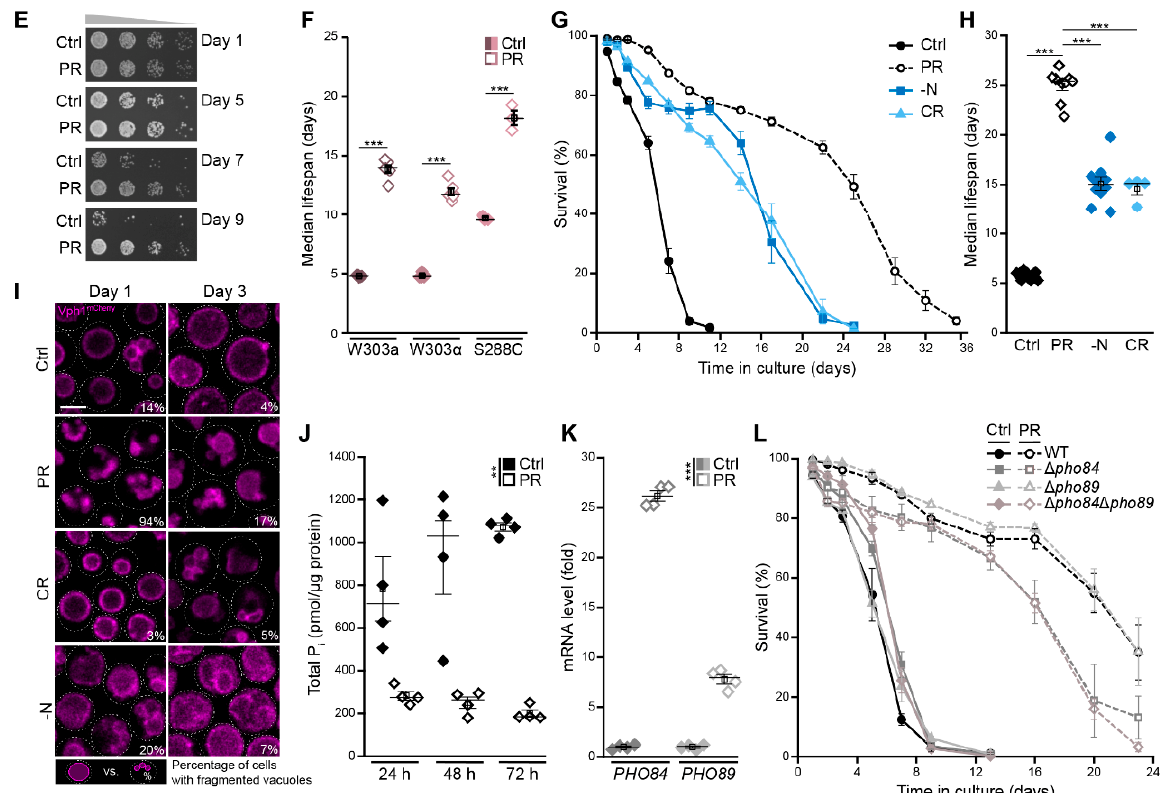
Figure 1. Phosphate restriction induces longevity. ( A ) Growth curves of wild type (WT; BY4742) cells on synthetic minimal glucose media with indicated phosphate (P i ) concentrations. OD 600 was recorded every 30 min using a BioscreenC microplate reader; n = 8. ( B , C ) Survival during chronological aging and ( B ) and corresponding median lifespan ( C ) of WT cells grown in media supplemented with 7 mM, 0.5 mM or 0.2 mM phosphate. Survival was determined by flow cytometric quantification of propidium iodide (PI) staining, indicating loss of membrane integrity and, thus, cell death; n = 4. ( D ) Clonogenic survival determined via survival plating and quantification of colony-forming units of WT cells grown on standard medium (Ctrl; 7 mM phosphate) or phosphate-restricted medium (PR; 0.2 mM phosphate). Survival was determined at indicated time points during chronological aging; n = 6. ( E ) Serial dilution spotting assays as a measure of regrowth capability of WT cells grown on Ctrl or PR media for indicated days. ( F ) Median lifespan of wild type yeast cells with different genetic backgrounds (W303a, W303 α , and S288C) grown on Ctrl or PR media; n = 3–6; ( G , H ) Survival during chronological aging ( G ) and corresponding median lifespan ( H ) of WT (BY4742) cells grown under different nutrient conditions: nitrogen starvation ( − N), caloric restriction (CR; 0.5% glucose), phosphate restriction (PR) (0.2 mM phosphate) and standard conditions (Ctrl). Survival was determined by flow cytometric quantification of PI staining; n ≥ 4. ( I ) Representative confocal micrographs of WT cells harboring endogenously mCherry-tagged Vph1 to visualize vacuoles indicated ( n = 4, with ≥ 42 cells per n and n = 4). Scale bar represents 3 µ m. ( J ) Relative levels of total phosphate (P i ) in